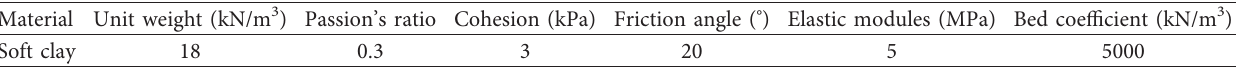
Figure 16: Relation between S and Q . Table 2: Mechanical parameters of soft clay